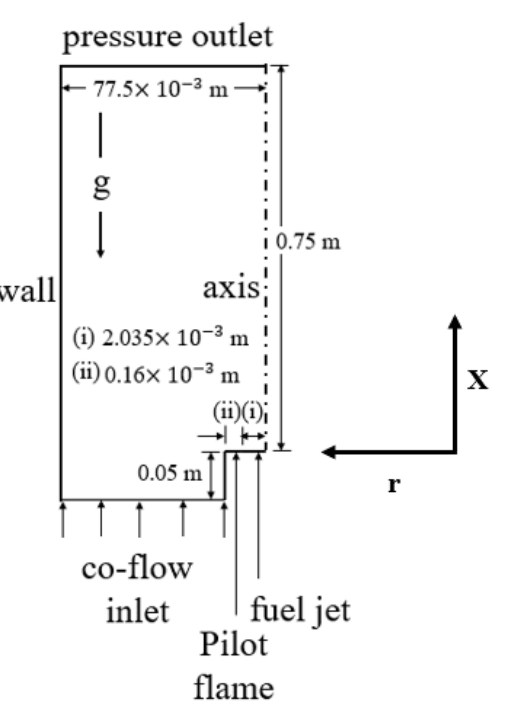
Figure 1. Schematic of the computational domain with dimensions (not to scale) .